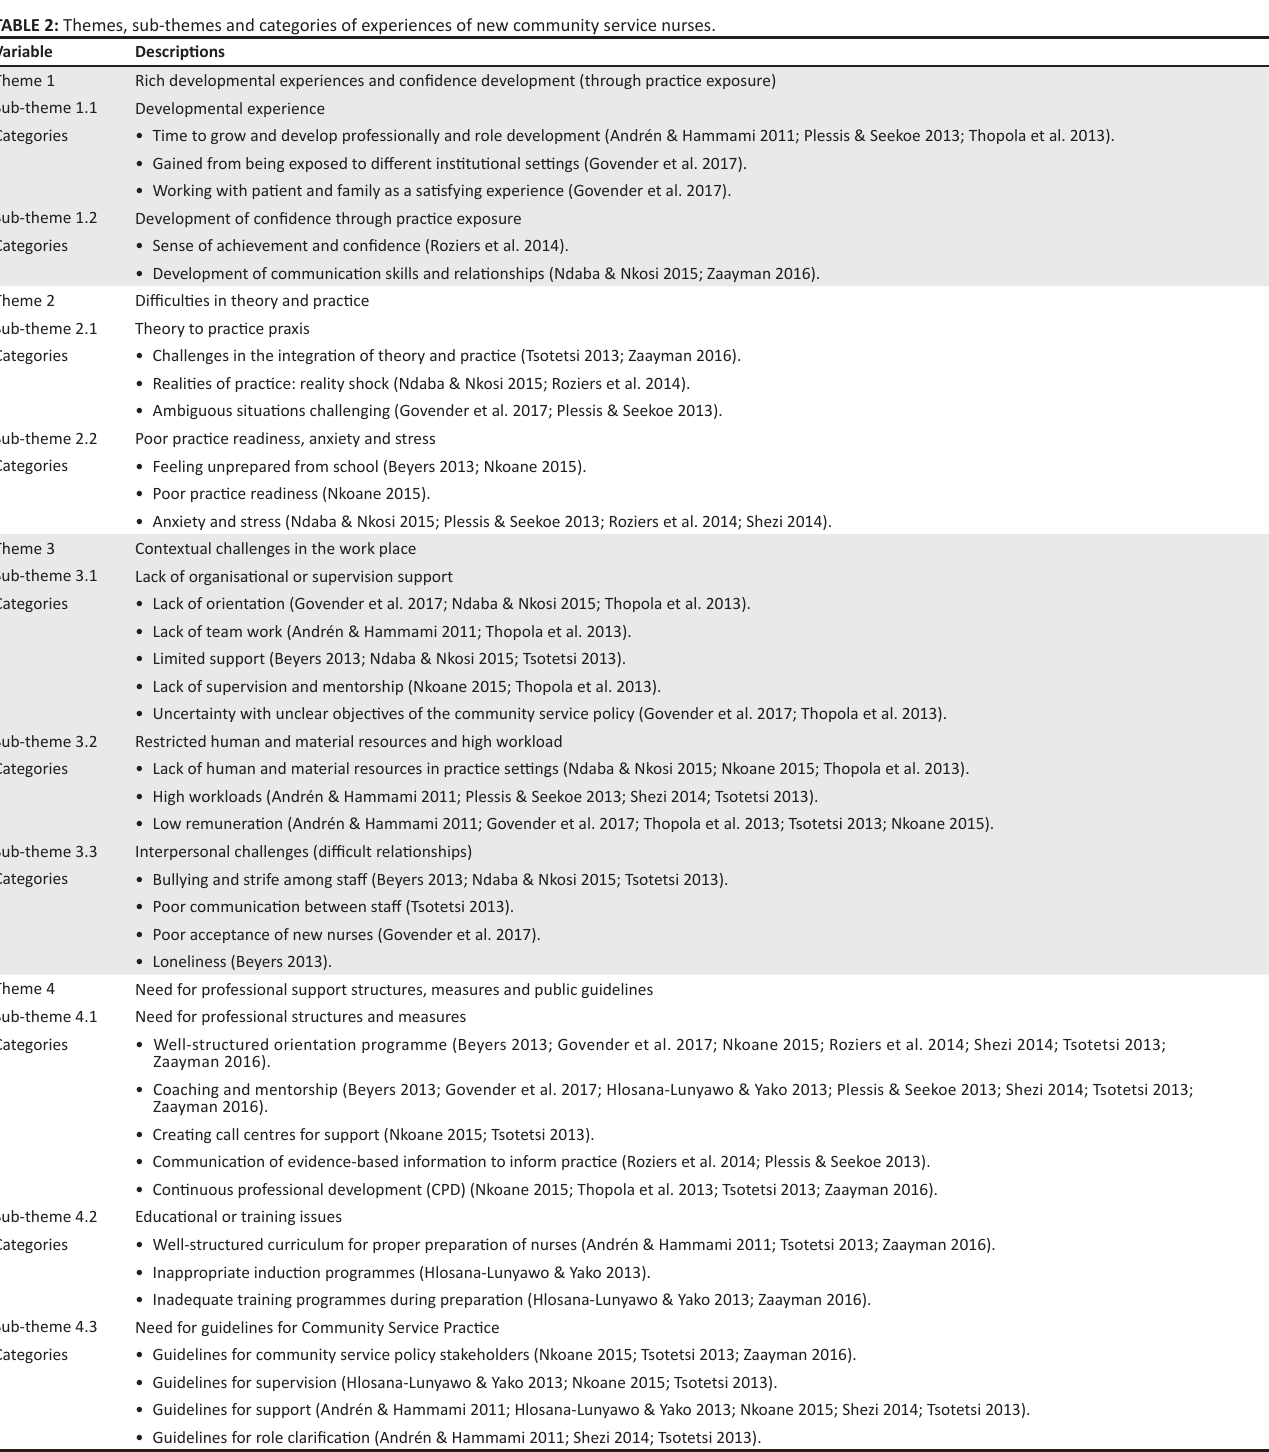
TABLE 2: Themes, sub-themes and categories of experiences of new community service